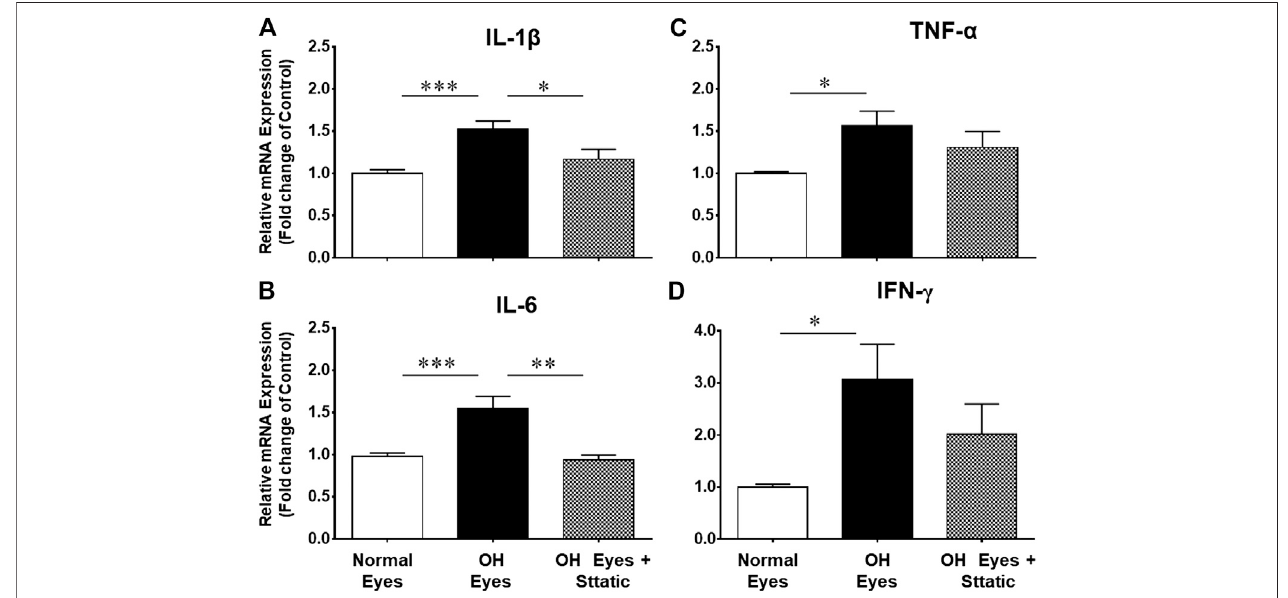
FIGURE7| InhibitoryeffectsofStattic,aselectiveSTAT3inhibitor,onthemRNAexpressionofIL-1 β (A) ,TNF- α (B) ,IL-6 (C) ,andIFN- γ (D) .Theretinafromnormal, ocularhypertensive,andStattictreatedocularhypertensiveanimalswerecollectedatday7,posthypertonicsalineinjection.ComplementaryDNAwassynthesizedfrom 1 µg total RNA extracted from retina. The relative changes in mRNA levels were measured by quantitative RT-PCR (qRT-PCR) using primers speci fi c for each gene as indicatedin Table1 .TheqRT-PCRdatawasnormalized using ß -actin geneexpression asaninternal control. Therelative expression wascalculated basedon the comparative threshold cycle (2 − ΔΔ Ct ) method. Bar graph represents mean data ± SEM. OH Eyes; ocular hypertensive eyes; OH Eyes + Stattic, ocular hypertensive eyes with Stattic treatment. * p < 0.05; ** p < 0.01; *** p < 0.001; n (cid:2) 6 – 9. In this experiment “ n ” represent a biological